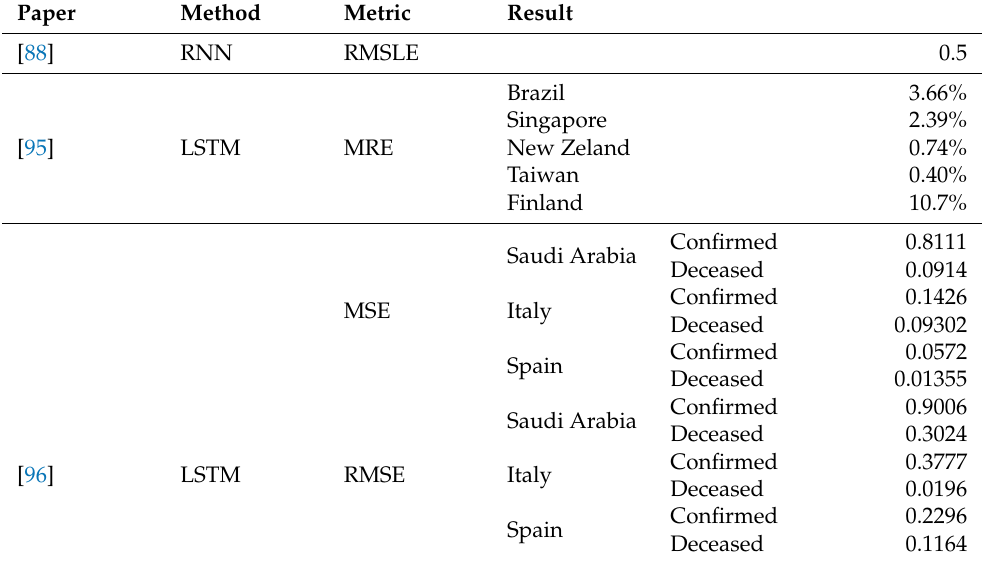
Table 6. Result comparison for RNN-based algorithms.